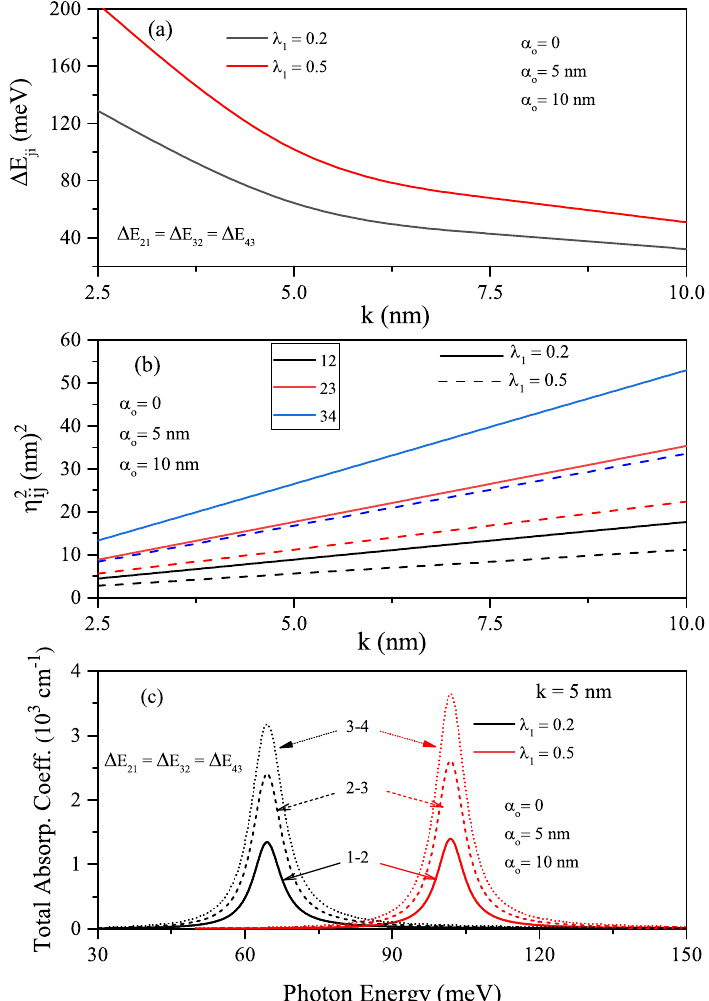
Figure 3. The variations of the energy differences between specified energy levels such as ∆ E 21 , ∆ E 32 , and ∆ E 43 of the electron confined in the HO potential as a function of the width k -parameter ( a ), the squared reduced transition matrix element corresponding to the stated levels as a function of the width parameter ( b ), and the total ACs versus the resonance photon energy for different values of laser-dressed α 0 -parameter and λ 1 -parameter ( c ). In the absence ( α 0 = 0-solid lines) and presence of the ILF ( α 0 = 5 nm-dashed (cid:2) (cid:3) λ 1 ( x / k ) 2 + λ 2 ( x / k ) 4 lines), the quartic single AHO potential, V ( x ) = V 0 , and squared wave function of the first four levels in relevant energy values versus the x -coordinate for k = 5 nm and λ 1 = λ 2 = 0.5 values are given in Figure 4a. The quartic single AHO potential also narrows under the influence of ILF and shifts towards higher energies. Figure 4b,c are shown the variations of the first four energy levels as a function of the k -parameter for a constant λ 1 value and two different λ 2 values in the absence and presence of ILF, respectively. For quartic single AHO potential, the variation of energies according to